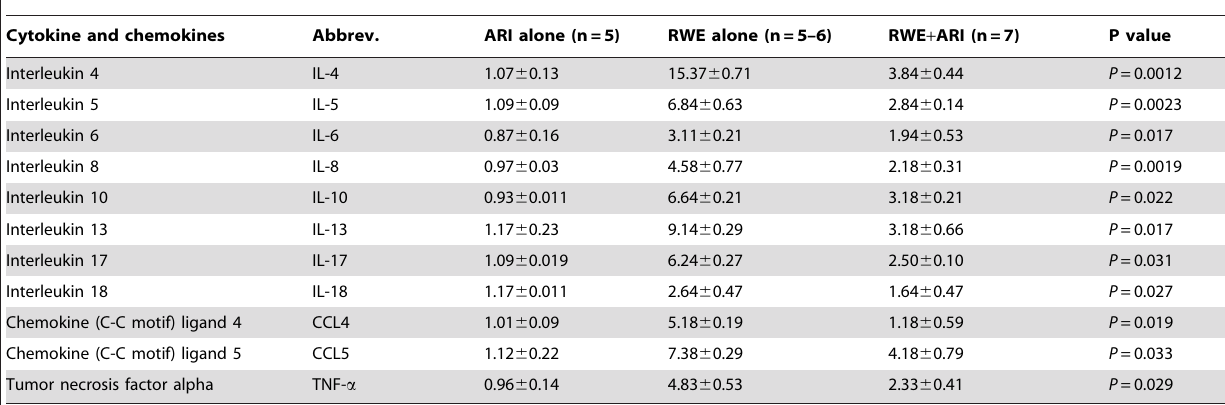
Table 1. AR inhibition prevents RWE-induced expression of cytokine and chemokines in mice lungs.